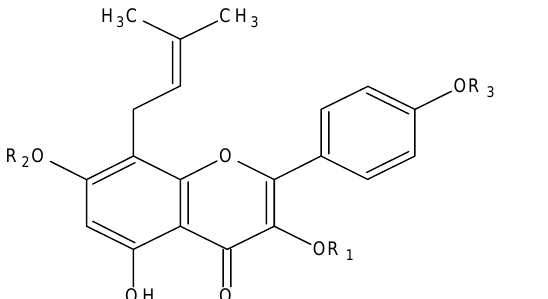
Figure 1. Chemical structures of five prenylated flavonoids isolated from Yinyanghuo or Epimedium koreamum Nakai: icariin, epimedin A, epimedin B, epimedin C, and baohuoside I. The symbol “glc” refers to glucose, “rha” to rhamnose, and “xyl” to